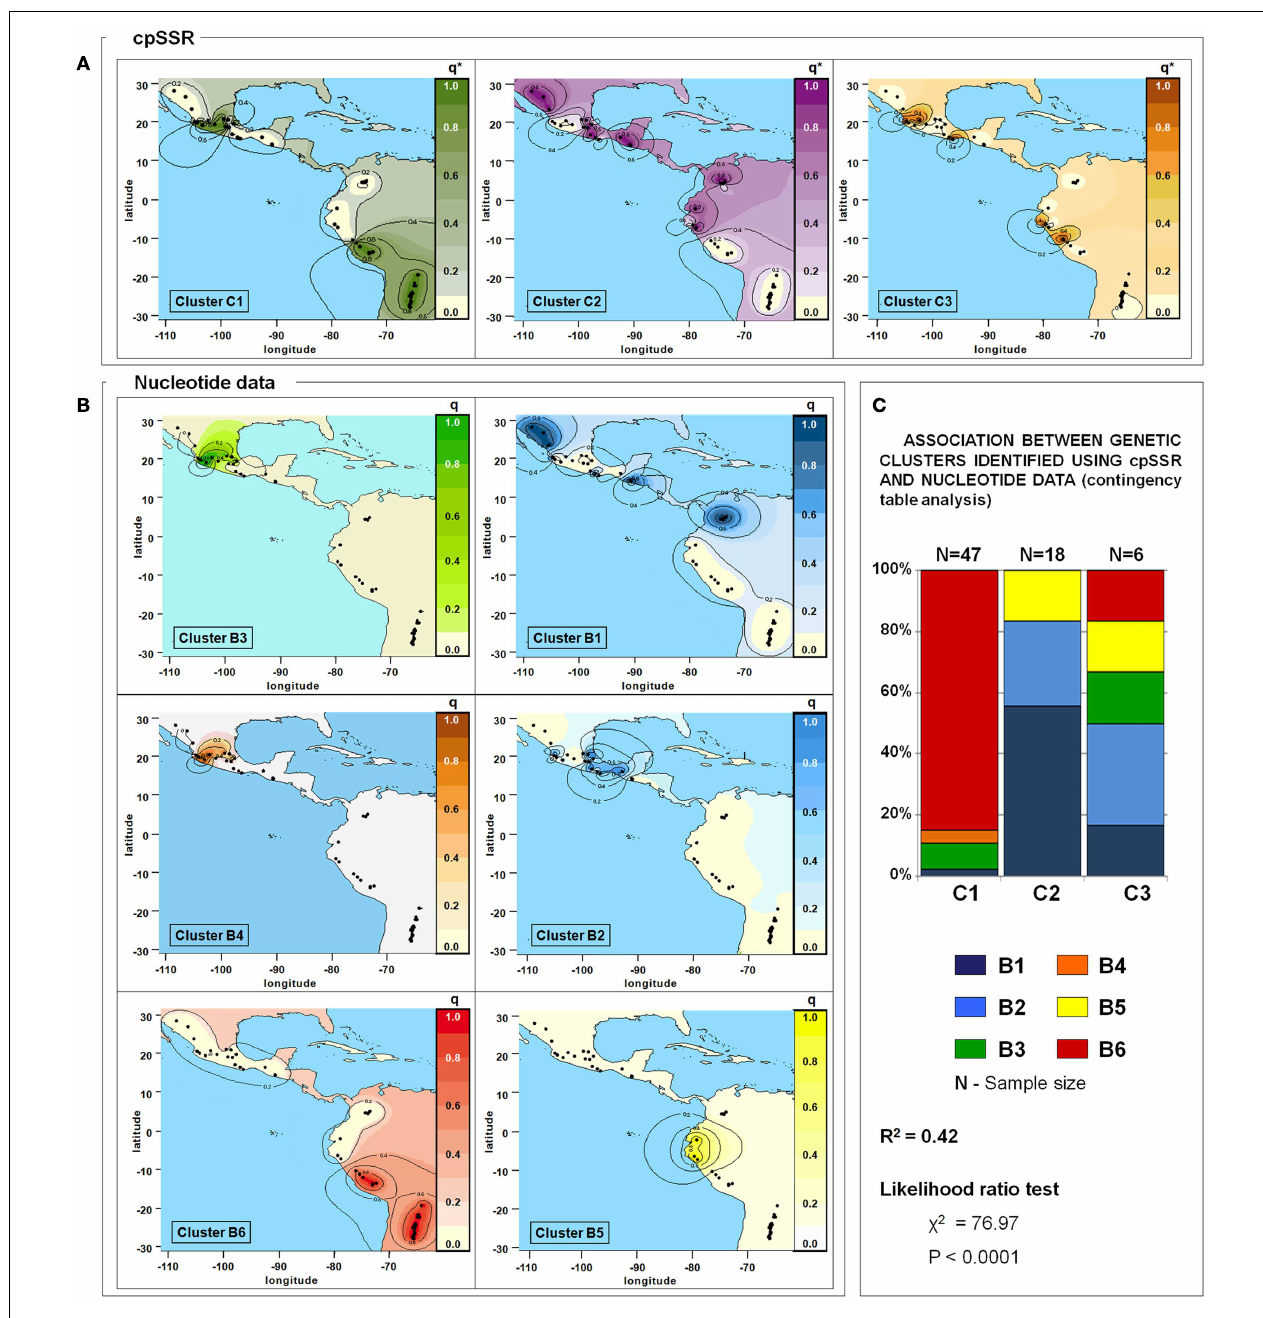
markers; indeed cpSSR q * values are represented by one or zero (i.e., membership or non-membership to one cluster), even if the spatial interpolation gives intermediate values. Only the 71 accessions shared between this study and that of Bitocchi et al. (2012) are included in this analysis. Latitude and longitude are expressed in the UniversalTransverse Mercator